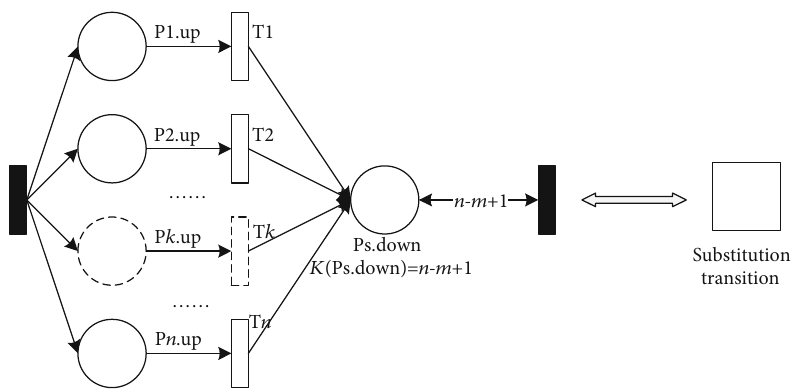
Figure 6: The static architecture represented by the substitution